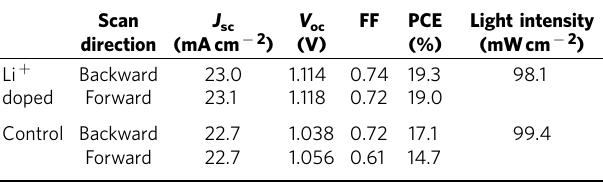
Table 1 | Solar cell performance